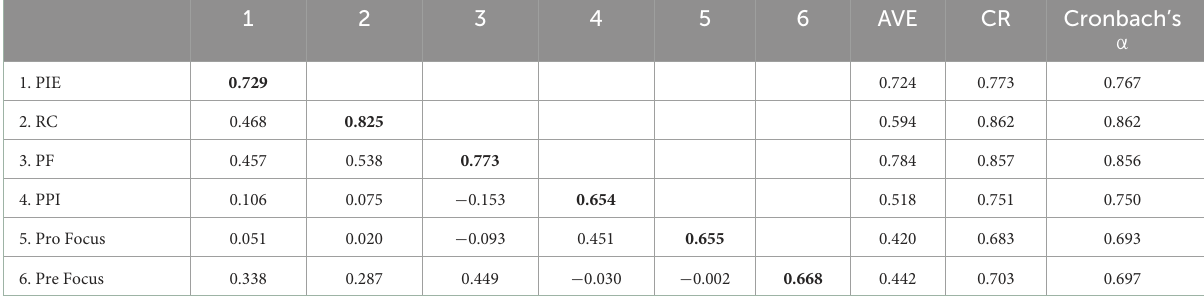
TABLE 2 Results of the validity and reliability.